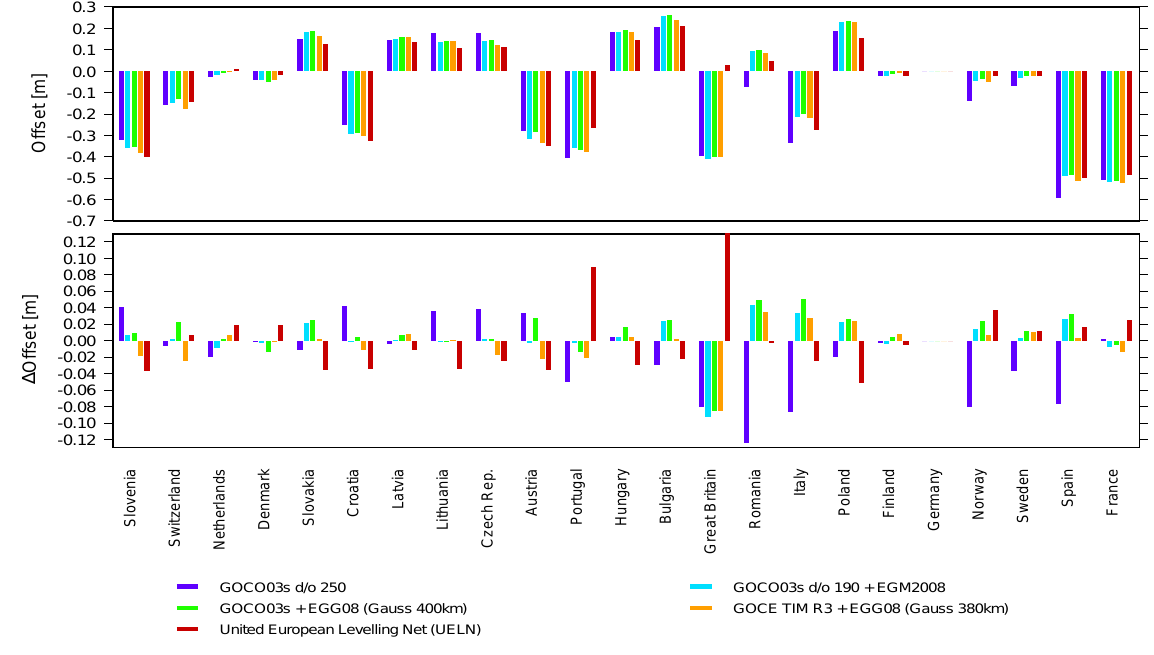
Figure 4. Comparison of the estimated height reference frame offsets based on GGMs to the results obtained from the United European Levelling Net (UELN). The offsets for Germany have been set to be zero. Top: absolute estimates. Bottom: An individual mean value has been subtracted for each